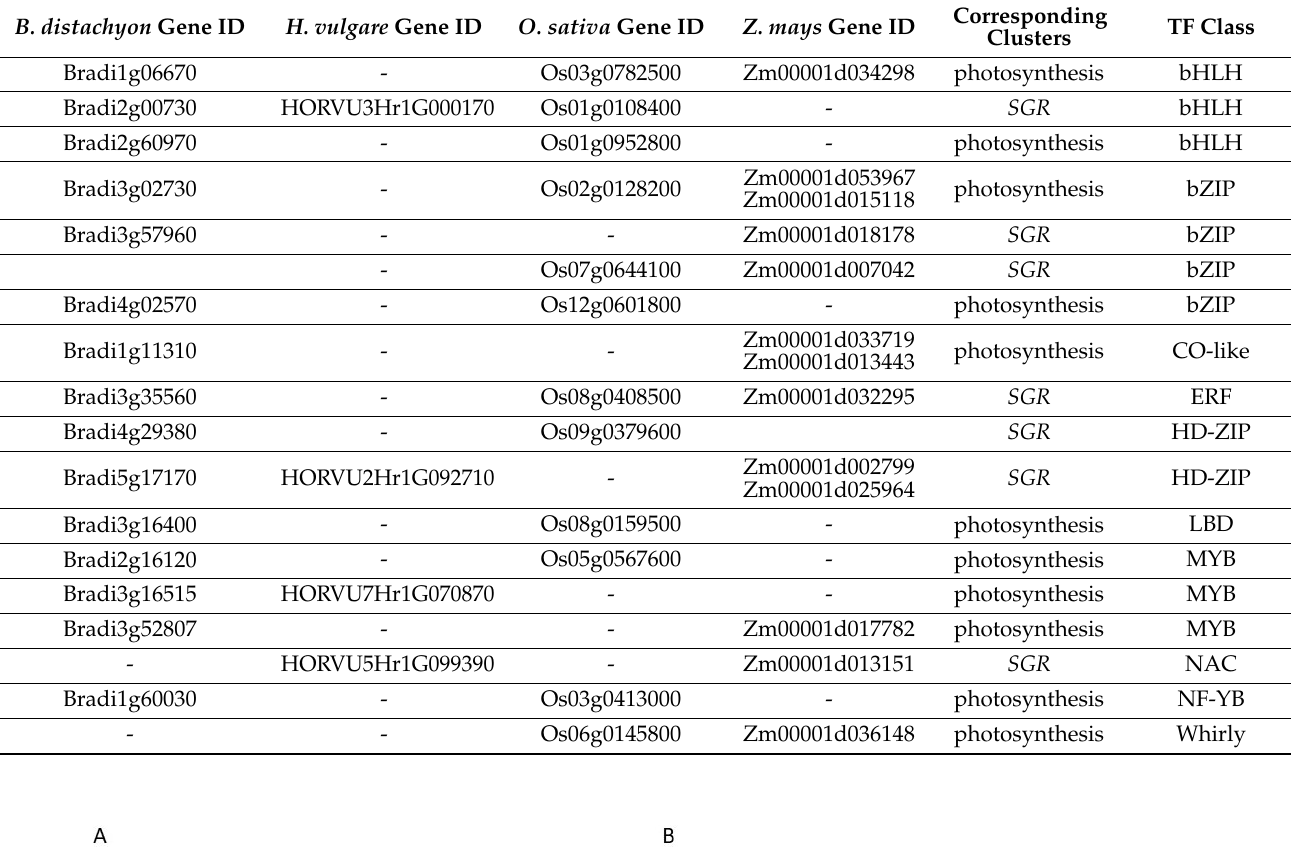
Table 5. Candidate TF genes related to drought tolerance across the four species.